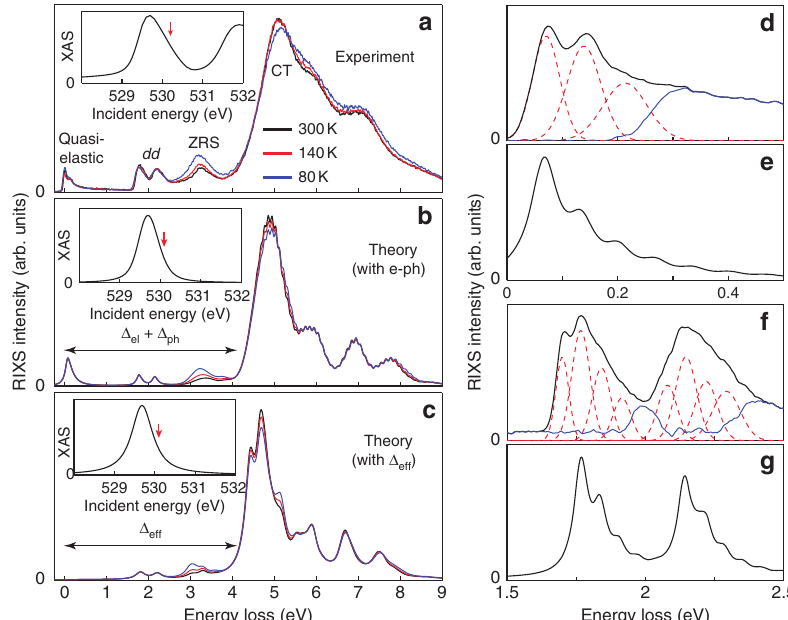
Figure 2 | XAS and RIXS spectra of LCO at the oxygen K -edge. ( a ) The measured RIXS spectra, recorded at various temperatures, as indicated. The incident photon energy for these measurements was detuned slightly from the upper Hubbard band peak in the XAS, as shown in the inset. The incident phonon energy is indicated by the red arrow. ( b ) The calculated RIXS spectra obtained using a cluster model that includes coupling to the O–O bond- stretching mode. The calculated XAS spectrum is shown in the inset. For comparison, c shows calculated spectra obtained from a model without coupling to the phonon mode and with an increased value of D ¼ E p (cid:2) E d (cid:3) 4 : 6eV. The detailed measured RIXS spectra highlighting the harmonic phonon excitations in the quasi-elastic and dd -excitation energy loss range are shown in d and f , respectively. Here, the red dashed lines show Gaussian fits to these data that highlight the individual phonon excitations. The blue line is the difference between the data and the red dashed lines. The corresponding RIXS calculations are shown in e and g , respectively. In d – g the incident photon energy coincides with the peak in the XAS intensity. Note that the elastic line has been removed from all of the calculated RIXS spectra for clarity. The spectra in e and g have been broadened using a Gaussian line shape with a s.d. of 60meV. In b and c this width was increased to 130meV to mimic additional broadening of CT features due to the bands formed by the O 2 p orbitals that are not well captured by our small Cu 3 O 8 cluster